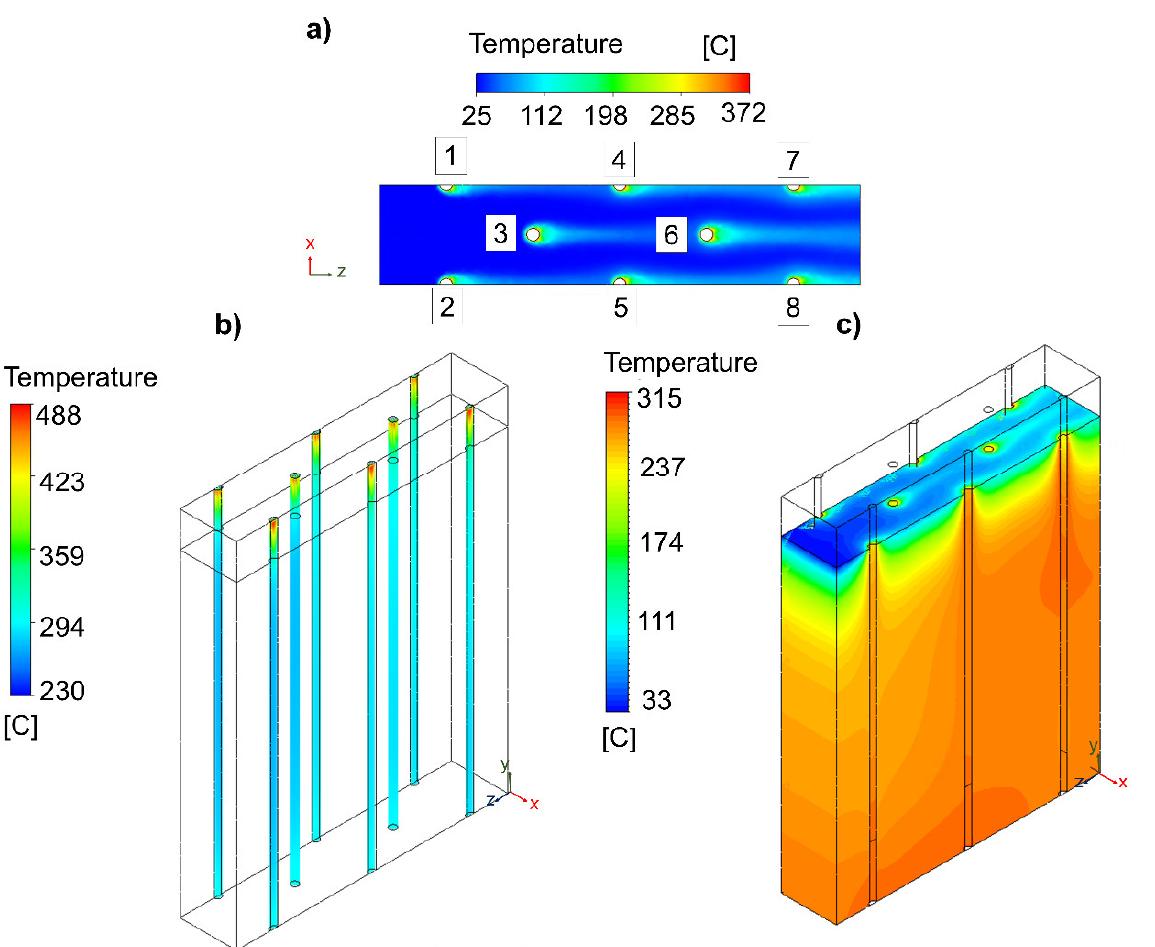
Figure 5. Influence of the reactive channel separation and height of the free-convective zone on the ( a ) air flow, ( b ) catalytic bed, and ( c ) insulating material. Specifications of the reactor design: number of reactive channels = 16; geometry configuration = hexagonal-shaped distribution; reactive channel length separation = 40 mm; free-reactive zone = 25 mm; insulation active zone = 225 mm.